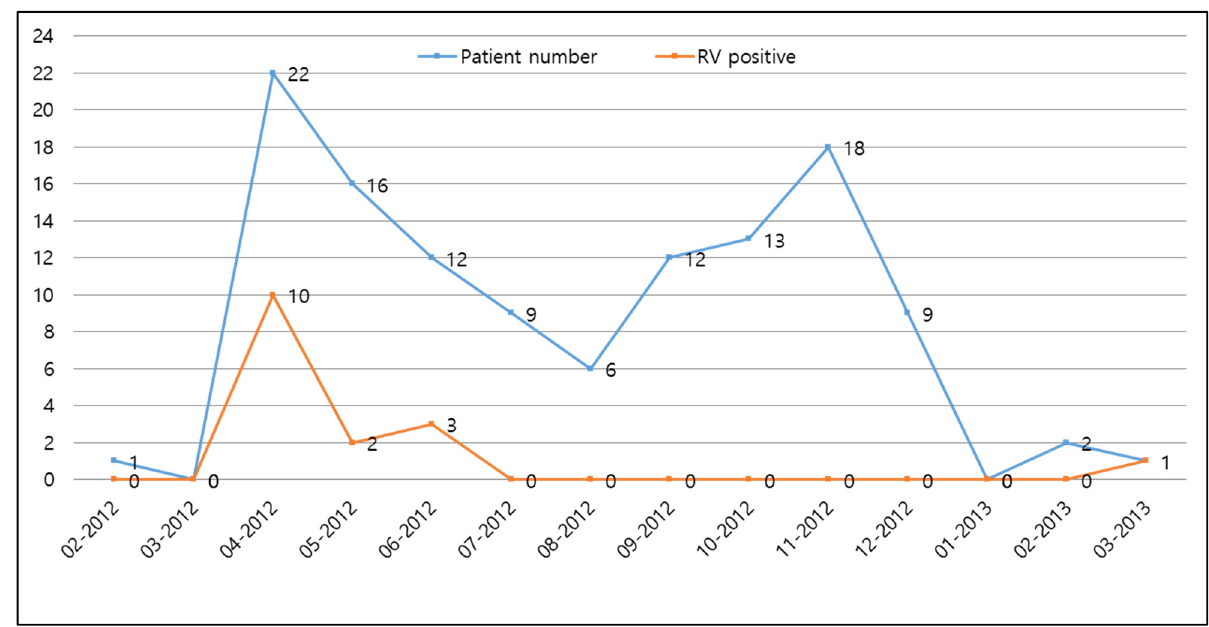
Figure 2. The monthly incidence of rotavirus infection in the pediatric ward from 20 February 2012, to 31 March 2013.